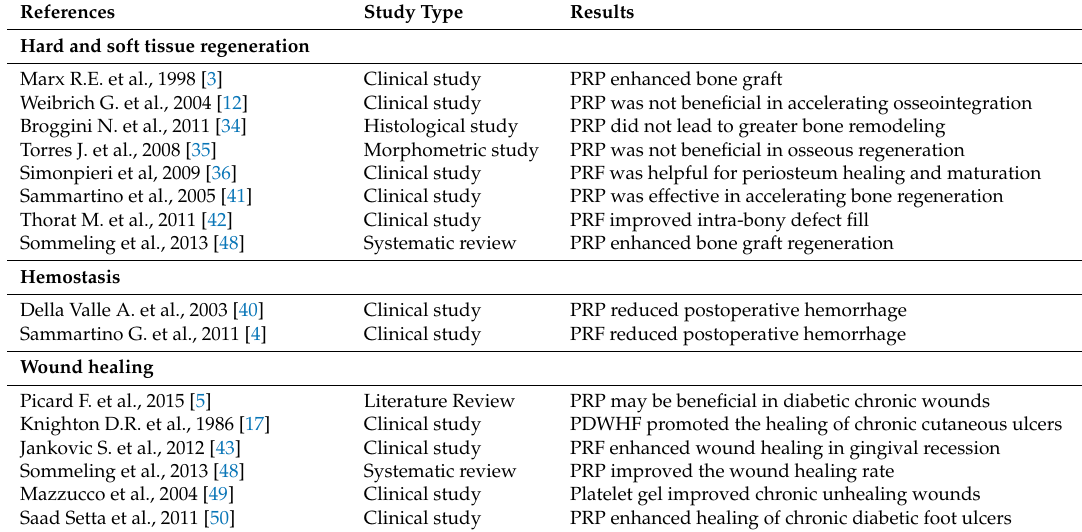
Table 1. Main articles included in the literature